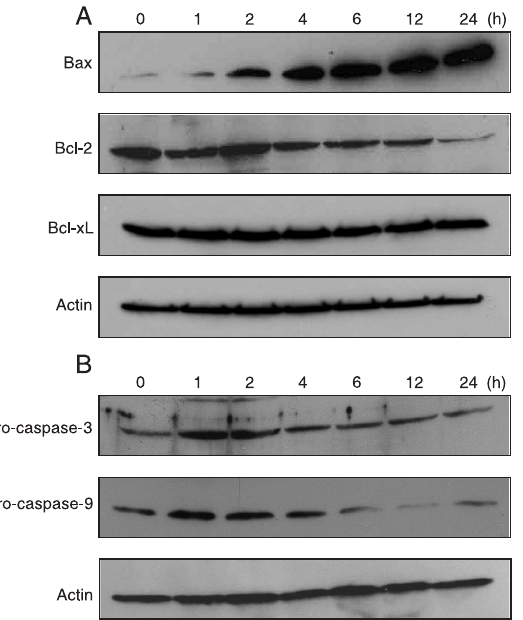
Figure 5. Expression of the apoptosis-related proteins Bax, Bcl-2, Bcl-x L , pro-caspase-3, and pro-caspase-9 in HT-29 cells by treat- ment with curcumin. A , Cells were incubated in serum-free medium overnight and further incubated for 0, 1, 2, 4, 6, 12, and 24 h in the presence of 50 µM curcumin. B , Cells were incubated in serum-free medium overnight and then further incubated for 6 h in the presence of 0, 10, 25, 50, and 75 µM curcumin, respectively. Equal amounts of cell lysates were resolved by SDS-PAGE and analyzed by Western blot using specific antibodies. The blots were re-probed with anti- actin antibody to confirm equal protein